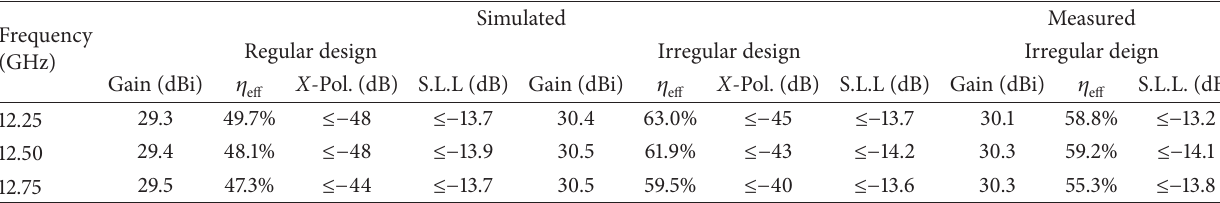
Table 3: The performance of the circular